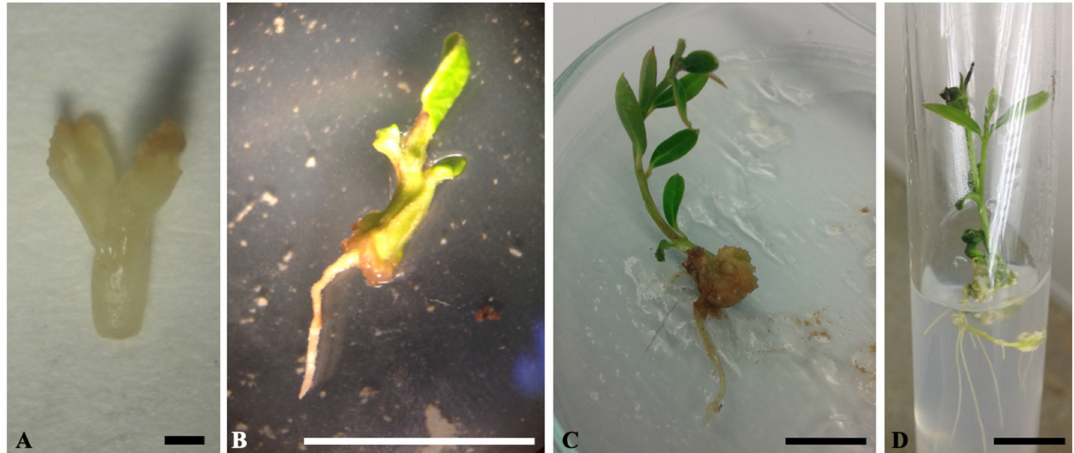
Figure 1. Somatic embryo germination and conversion into plantlet under 16 h photoperiod. ( A ) Mature somatic embryo. ( B ) Somatic embryo germination on half-strength OM medium supplemented with 0.1 mg · L − 1 GA3 and 0.1 mg · L − 1 NAA. ( C ) and ( D ) Somatic embryo development and conversion into complete plantlet. Bars correspond to 1 mm (A) and 1 cm (B–D). Table 2. E ff ect of di ff erent culture media on somatic embryo germination and conversion into plantlets. Germination and Secondary Culture Medium Conversion into Embryogenesis Plantlets (%)